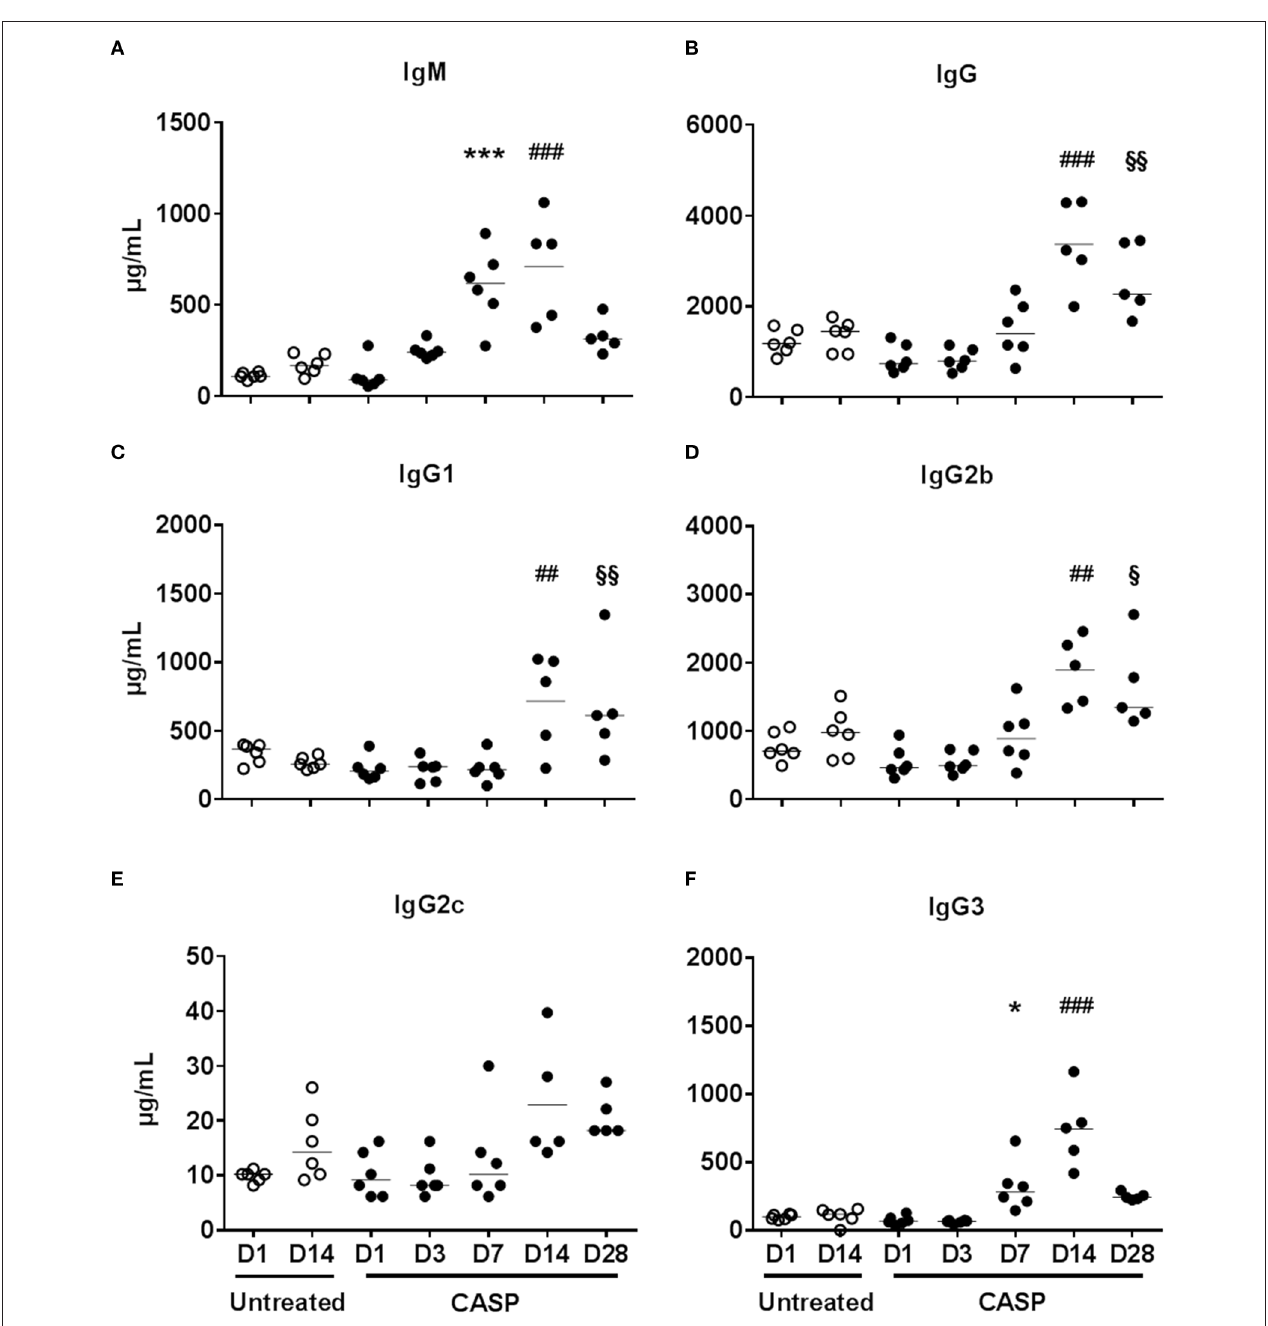
FIGURE 1 | Serum immunoglobulin concentrations during the course of sepsis. Sepsis was induced by CASP-operation in female C57BL/6 mice. Untreated animals served as controls. At the indicated time points animals were anesthetized and blood was collected. Serum IgM (A) and IgG (B) concentrations, as well as the concentrations of all IgG-subtypes (C-F), were measured by Luminex ® -technology. One of two similar experiments is shown here. We used the One Way ANOVA and Bonferroni post hoc test for selected pairs for statistical evaluation, and the mean is depicted in this figure. Significances are shown as number of symbols. one symbol p < 0.05; two symbols p < 0.01; three symbols p < 0.001. (*) CASP D7 vs. untreated D1, ( # ) CASP D14 vs. untreated D14, ( $ ) CASP D28 vs. untreated D14; N = 5-6/group. The 95% confidence intervals of the differences of means are given in Supplementary Tables 1 , 2 .